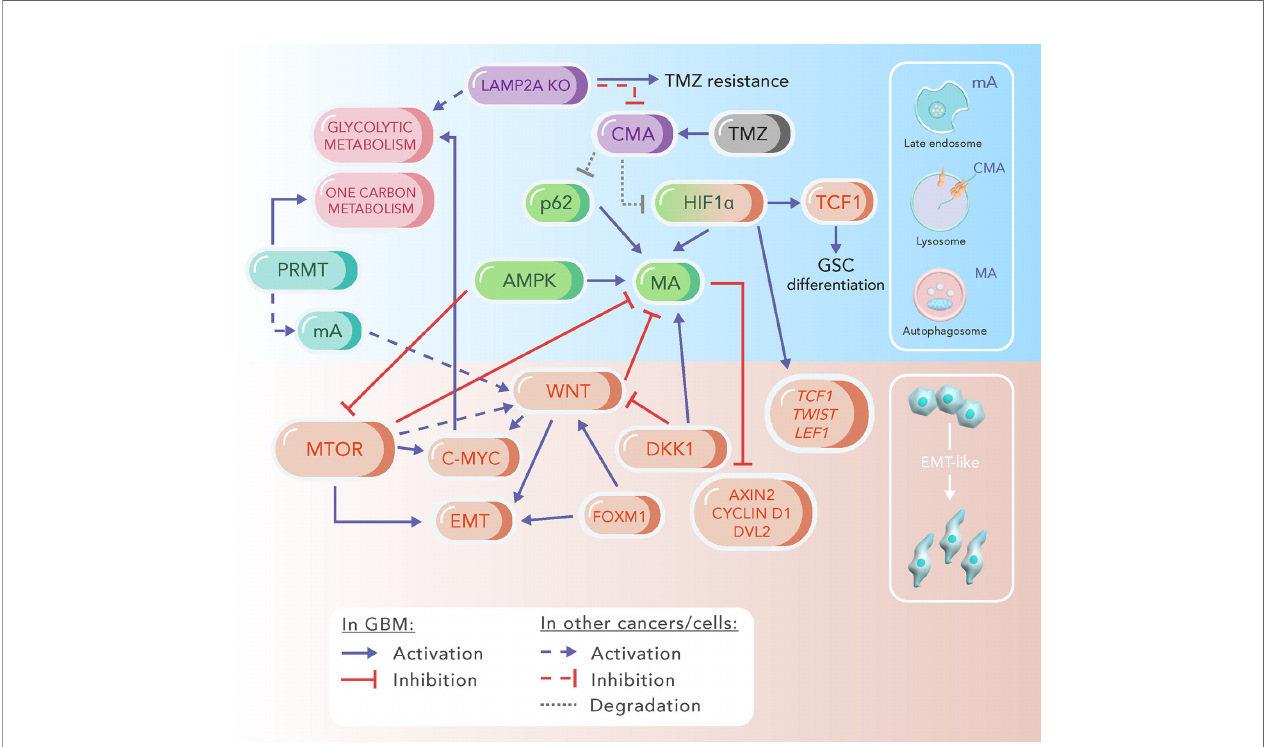
FIGURE 2 | Schematic representation of signaling pathways involved with WNT/ b -catenin, autophagy and epithelial-to-mesenchymal transition (EMT) in glioblastoma (GBM). The major players of the highlighted processes are grouped by a colour code, which differentiates microautophagy (mA, light blue), chaperone-mediated autophagy (CMA, purple), macroautophagy (MA, green), EMT (orange) and some metabolic processes (pink). AMPK, AMP Kinase; DKK, Dickkopf; DVL2, dishevelled 2; FOXM1, forkhead box protein M1; HIF1a, hypoxia-inducible factor 1a; LAMP2A KO, knockout of LAMP2A protein; LEF1, lymphoid enhancer factor 1; mTOR, mammalian target of rapamycin; PRMT, protein arginine methyltransferase; TCF1, T-cell factor 1; TMZ,